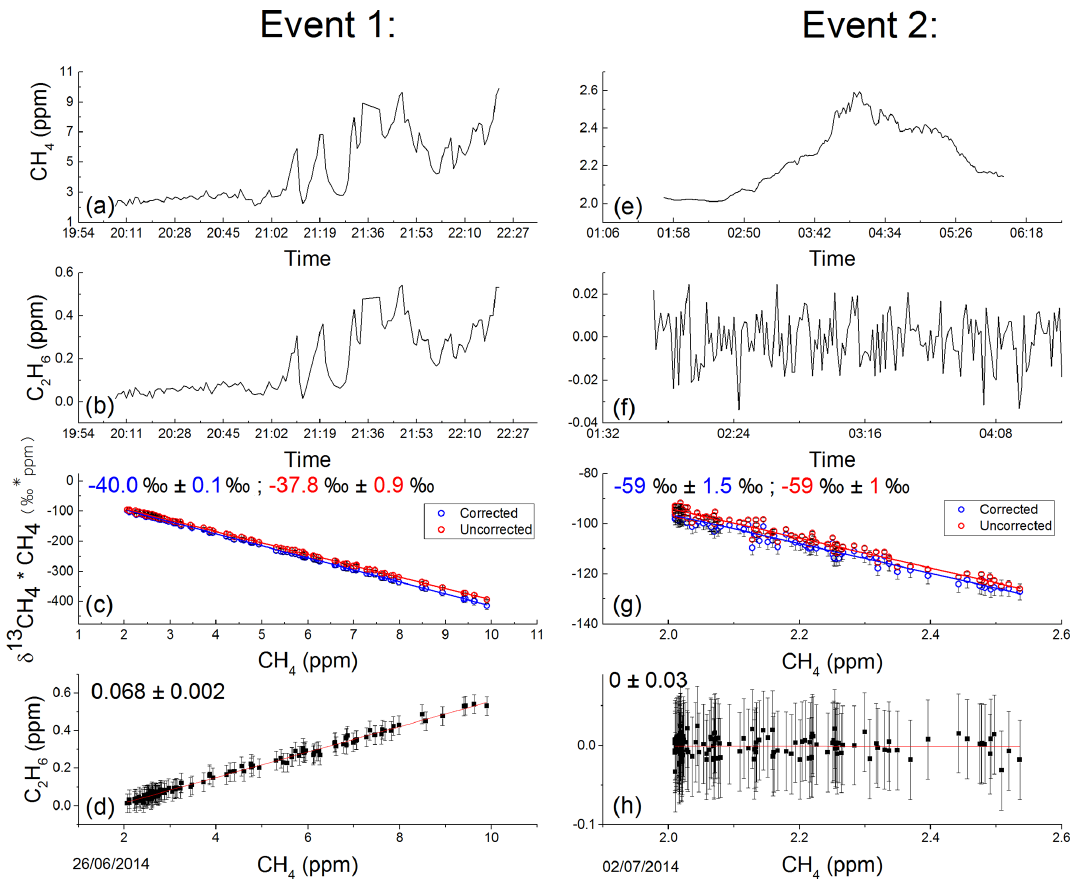
Figure 10. Ethane and methane content of two selected peaks. Methane and ethane 1min averaged time series is shown in (a) and (b) for Event 1 and (e) and (f) for Event 2. Miller–Tans plots of the corresponding peaks are shown in (c) and (g) , blue for the corrected δ 13 CH 4 due to C 2 H 6 , and red representing uncorrected δ 13 CH 4 . Event 1 includes elevated C 2 H 6 emissions and thus displays a difference between the slope before and after C 2 H 6 correction, corresponding to a shift in isotopic signature. Event 2, with no C 2 H 6 shows no alteration in slope. The slopes of C 2 H 6 vs. CH 4 are shown in (d) and (h) , signifying the C 2 H 6 :CH 4 ratio of the emission. Errors of both the isotopic and C 2 H 6 :CH 4 signatures are calculated from the standard error of the